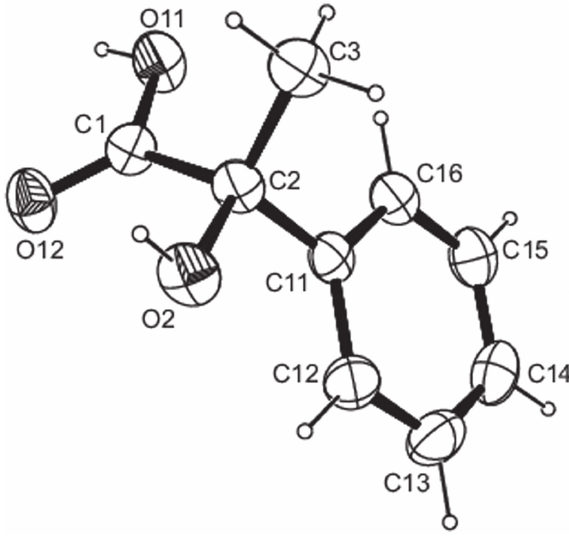
Table 1: Data collection and handling.